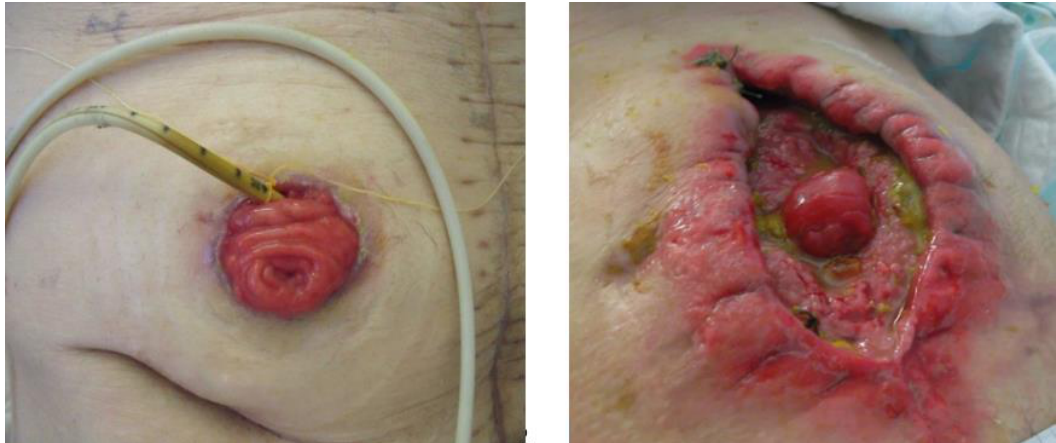
Figure 1. Double enterostomy (left) with a tube placed in the downstream intestine to reinfuse the chyme. Entero-atmospheric fistula (right) where the small intestine is poured out of the abdomen, located in a wound in the wall and behaves like a double enterostomy.